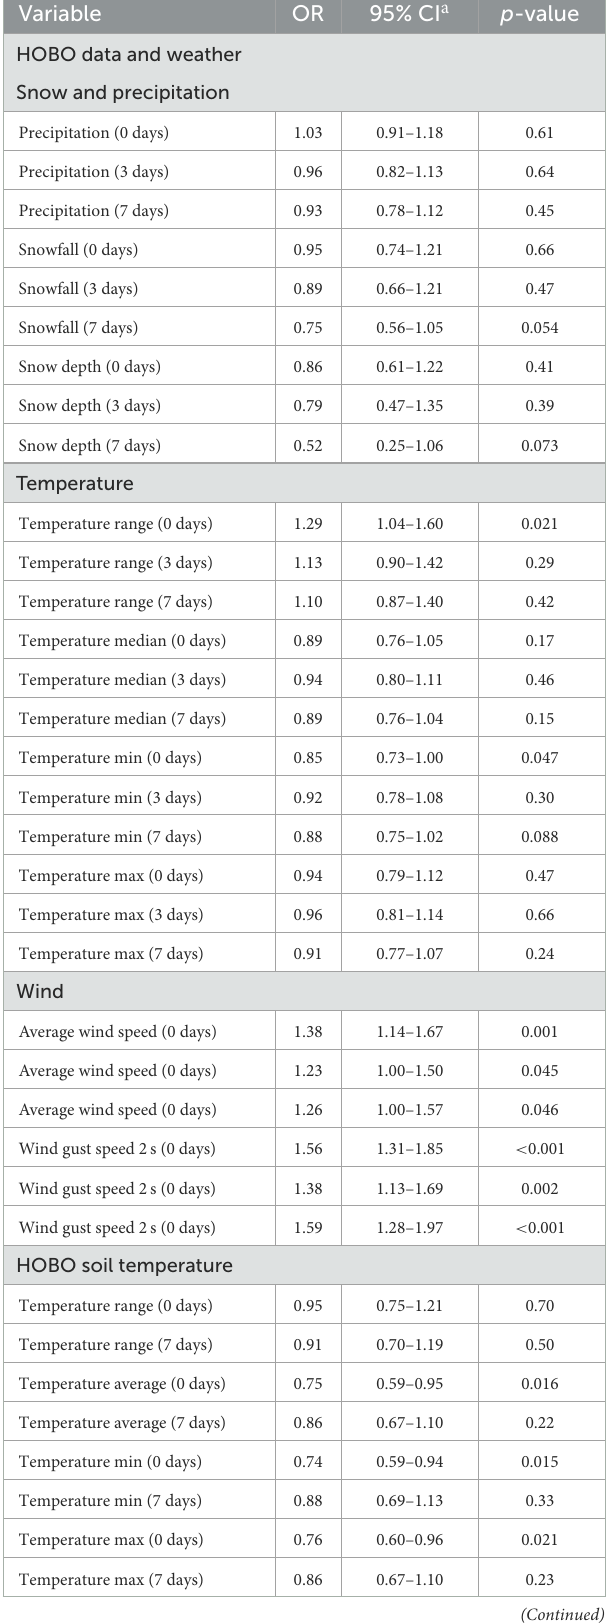
TABLE 2 Univariable analysis, using a mixed-effect logistic regression model, of the weather and HOBO-related factors that influence the likelihood of non-O157 STEC presence in soil samples amended with untreated manure in certified organic